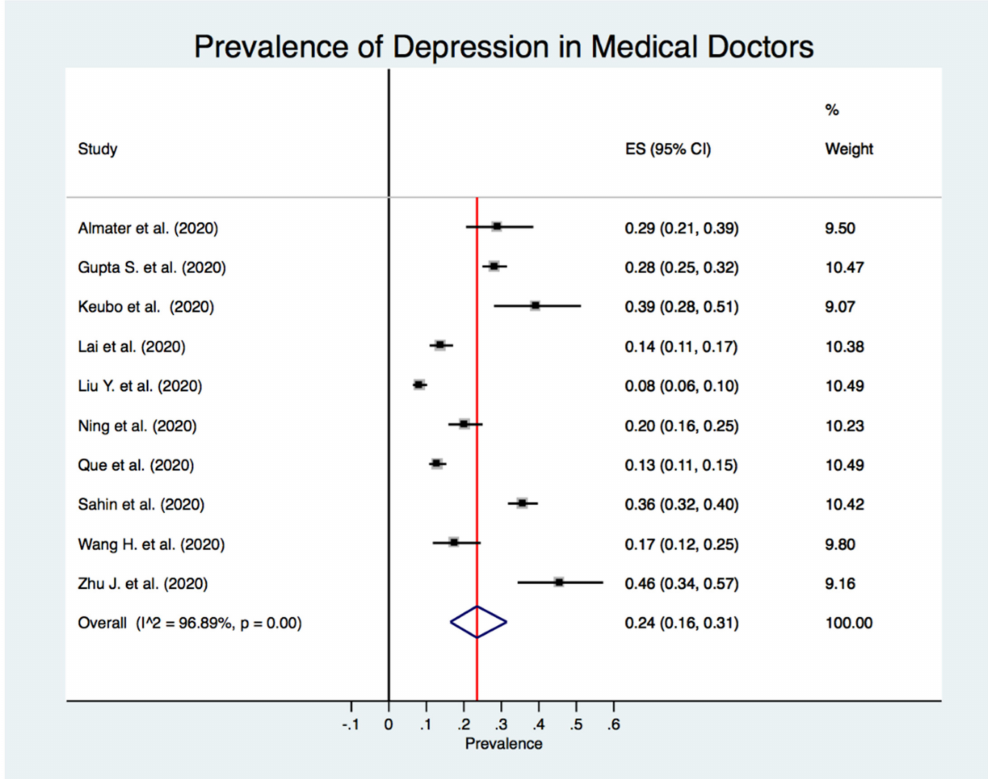
Figure 4. Forest plot for the prevalence of depression among medical